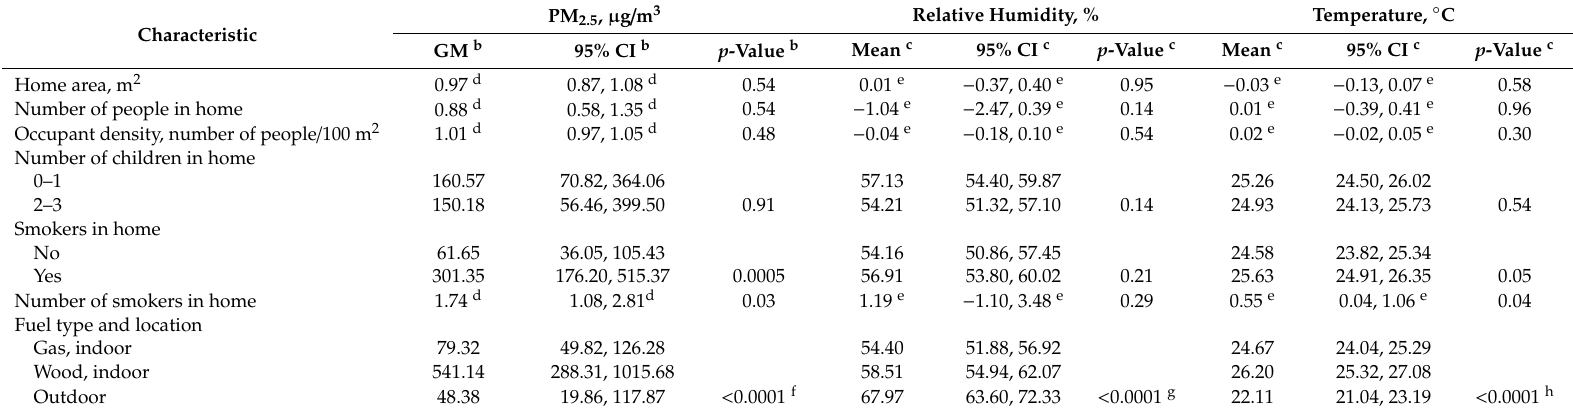
Table 3. Associations between home characteristics and the mean of samples inside or outside a homes at a brick kiln in Bhaktapur, Nepal, May 2019. PM 2.5 , µ g / m 3 Relative Humidity, % Temperature, ◦ C Characteristic GM b 95% CI b p -Value b Mean c 95% CI c p -Value c Mean c 95% CI c p -Value